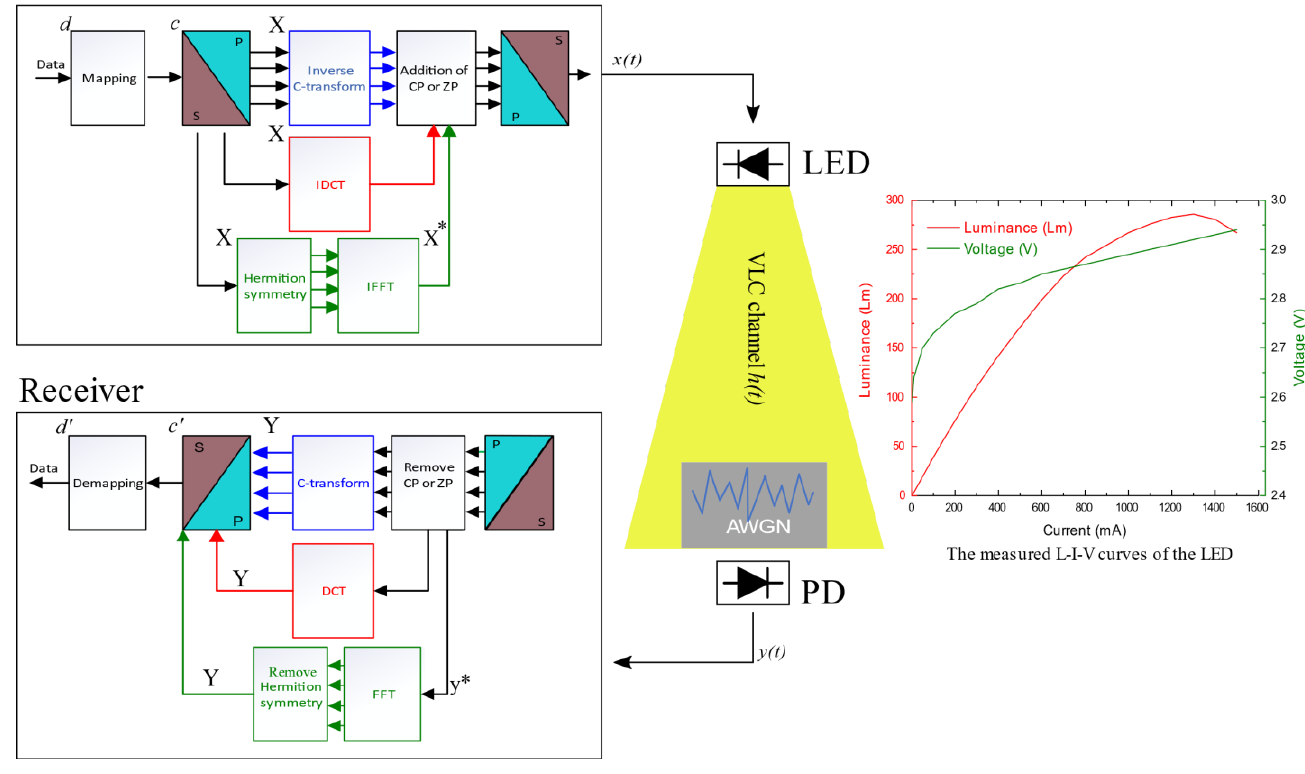
Figure 2. System block